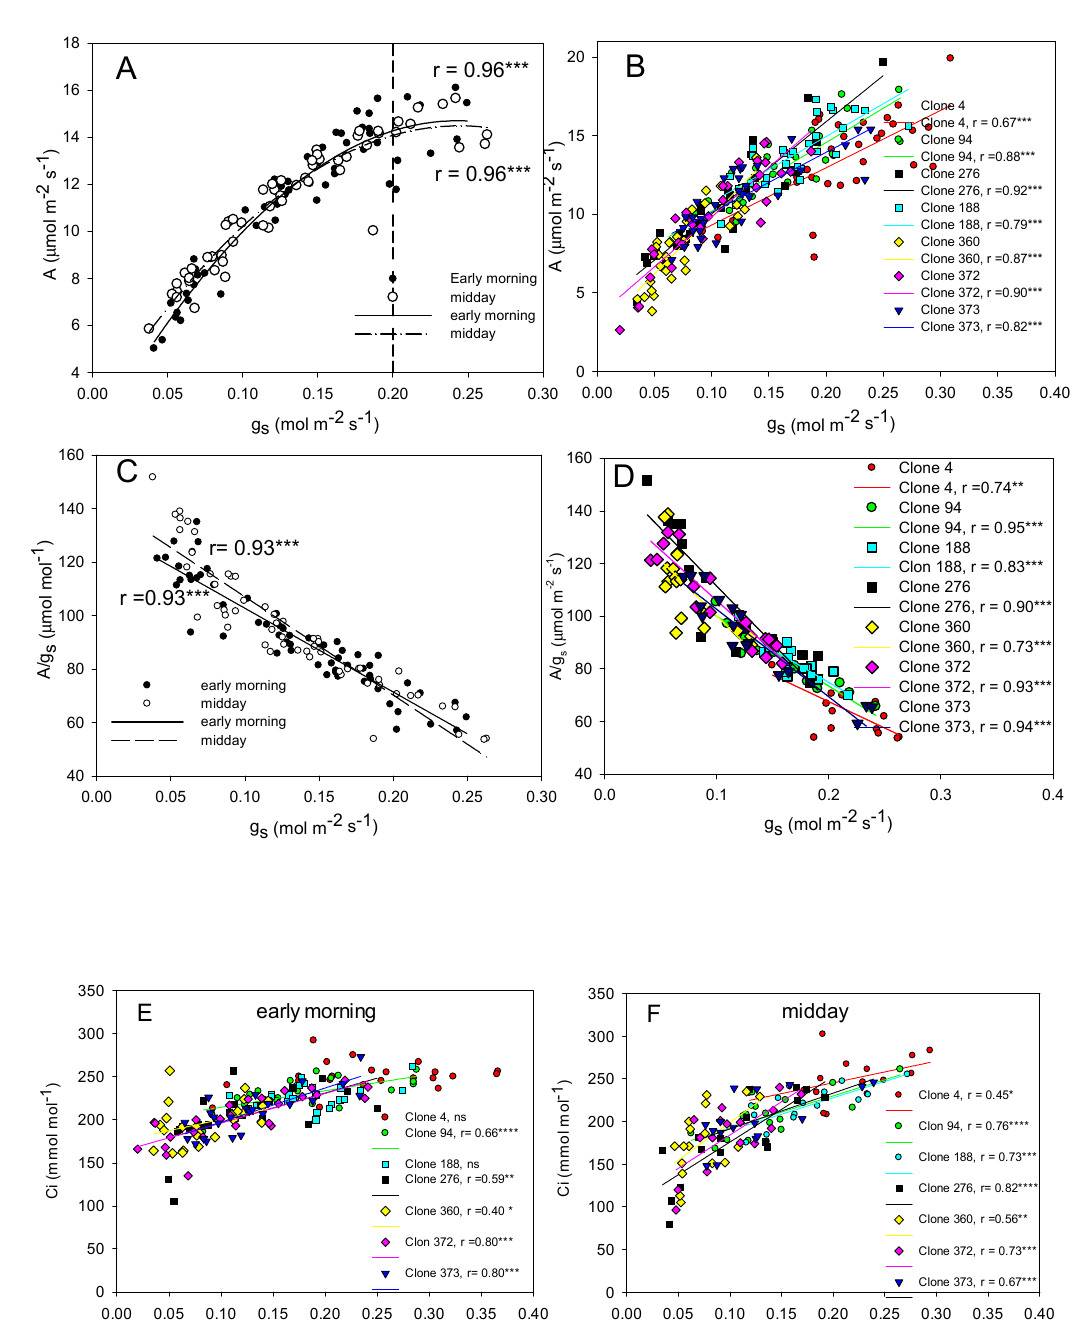
Figure 8. ( A ). Significant relationships between A and g s at early morning and midday during post-veraison in 2020. ( B ). Significant relationships between g s and A for each clone in the morning (including early morning and midday) during post-veraison in 2020. ( C ). Significant relationships between g s and A/g s at early morning and midday during post-veraison in 2020. ( D ). Significant relationships between g s and A for each clone in the morning (including early morning and midday) during post-veraison in 2020. ( E , F ). Significant relationships between stomatal conductance ( g s ) and intercellular CO 2 concentration (Ci), for each clone at early morning (9:00–10:30 a.m.) and midday (12:30–14:00 p.m.), respectively. Each single point is the average of three measurements made in different dates in the leaves of the same vine under control and stress conditions during post-veraison in 2020. * p < 0.1; ** p < 0.05, *** p < 0.01; **** p <